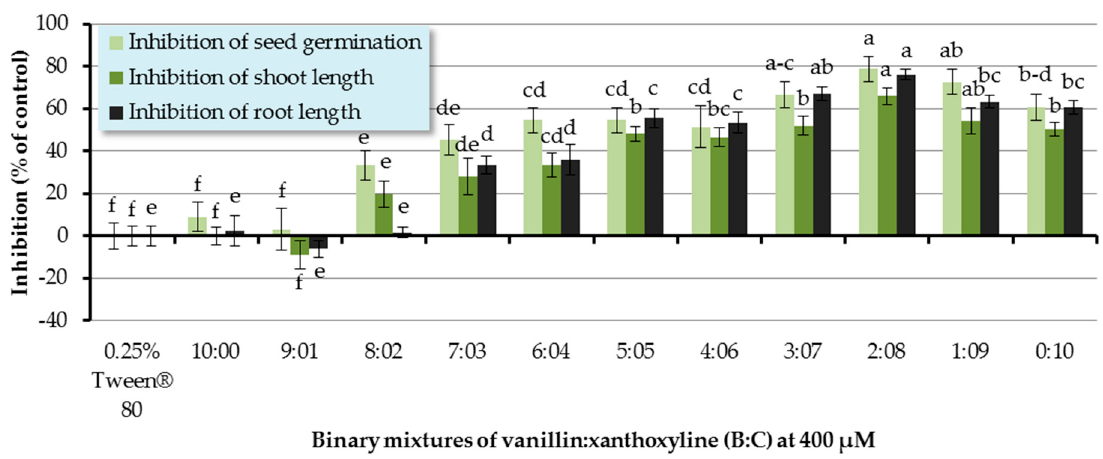
Figure 5. Inhibitory effects of binary mixtures (at 400 μ M) of vanillin ( B ) and xanthoxyline ( C ) on seed germination and shoot and root growth of Chinese amaranth. A 0.25% aqueous solution of Tween ® 80 was used as a control. Means with the same letters in the graph are not significantly different at p ≤ 0.05 level.